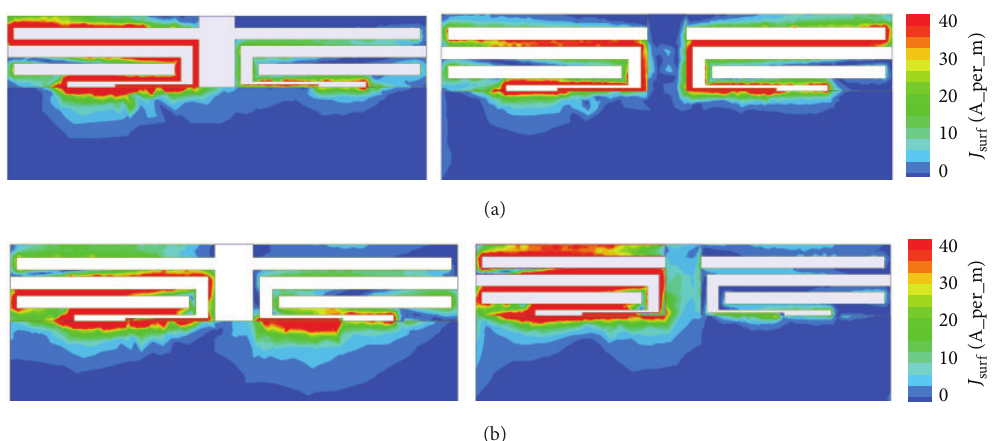
Figure2:Simulatedsurfacecurrentdistributionsontheantennaelementsandthesystemgroundplane:(a)925 MHzwith(right)andwithout (left) the protruded ground. (b) 2500 MHz with (right) and without (left) the protruded ground.